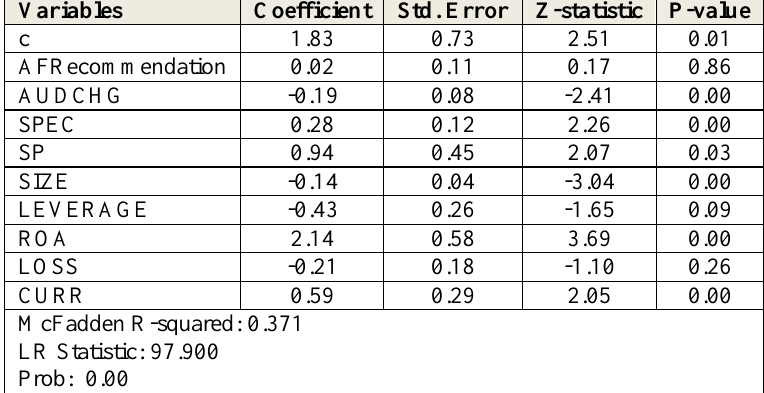
Table 4. The results of testing the second hypothesis Variables Coefficient Std.